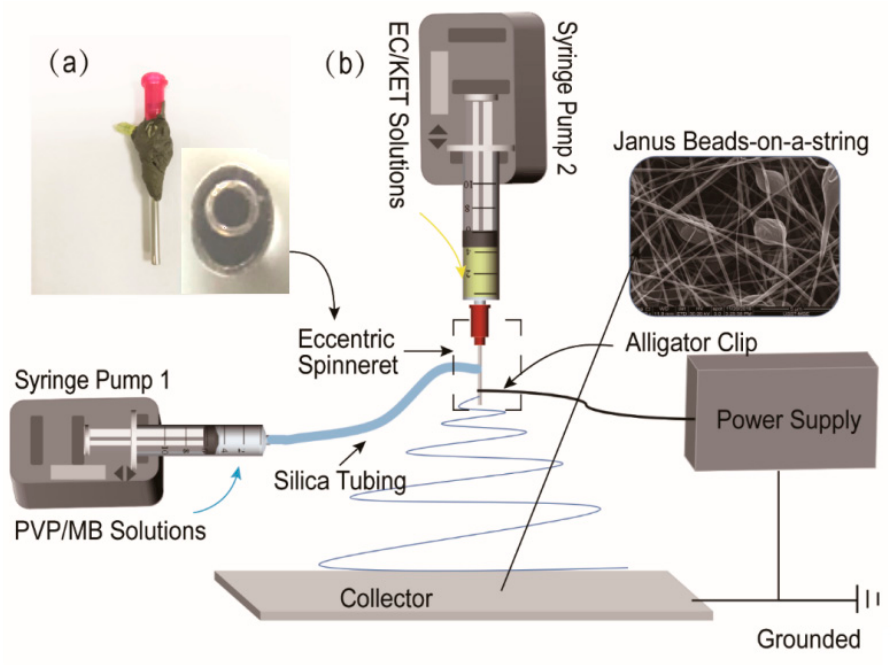
Figure 1. The implementation process of side-by-side electrospinning: ( a ) an image of a home-made eccentric spinneret; ( b ) schematic drawing of the home-made electrospinning system. A digital image of the home-made side-by-side electrospinning system appeares in Figure 2a. Two syringe pumps were used for driving two different working fluids independently. The syringe containing the PVP-MB solution fixed to the pump was directly linked to the round side of the spinneret through a silicone tube. The other side of EC-KET solution loaded into another syringe pump was connected to the crescent side. High- voltage electrostatic can be transmitted into all fluids utilizing an alligator clip. Figure 2b shows the process of connecting the spinneret with fluids and the high-voltage. Under the pre-optimized working parameters (voltage of 12 kV, the flow rate of 0.8/ 1.0 mL · h − 1 for EC/PVP side), all fluids could work continuously and stably in side-by-side electrospinning. A typical Taylor cone was shown in Figure 2c. Additionally, Figure 2d depicts that two working fluids were concurrently ejected from the Taylor cone and moved through the straight jet, followed by bending and whipping. The solvent of working solutions evaporated, and the polymers solidified and dried on the collector to form fiber mats. The typical phenomenon indicated that two sides had better compatibility and not separate under the high-voltage electrostatic field. By the way, solvent selection is a key issue for implementing a successful single-fluid electrospinning process in terms of solubilities of the solutes, spinnability of the blending solution and also the exhaustion in the solid nanofibers for applications such as drug delivery and tissue engineering [70–74]. For the double-fluid side-by-side process, the selections of solvents for both sides should be paid more attention to ensure the two working fluids have good